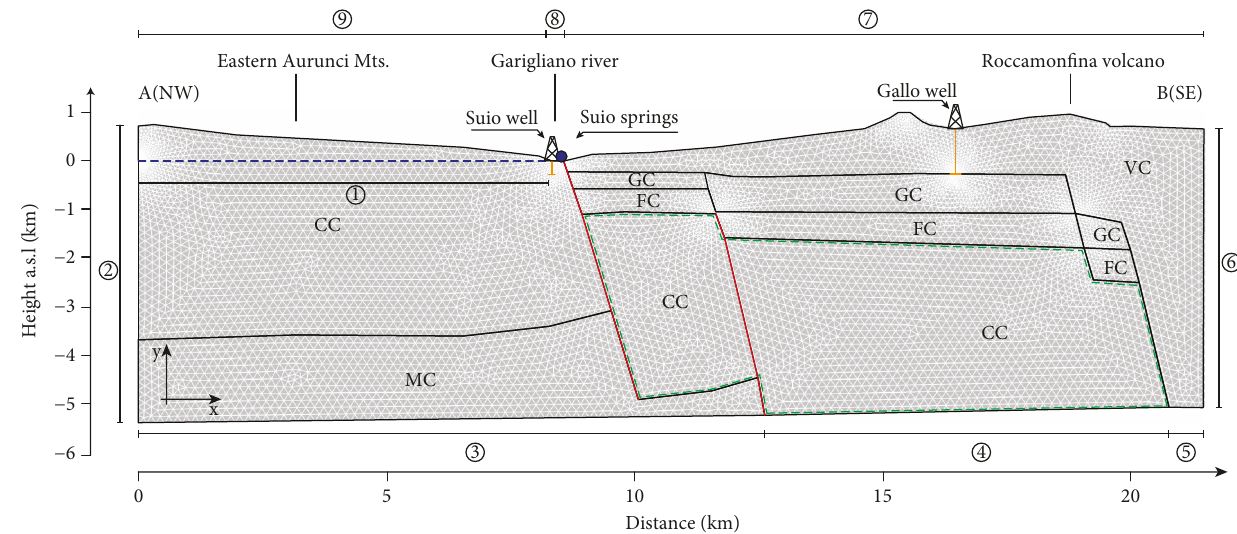
Figure 4: A 2D fi nite element model derived from the hydrogeological section in Figure 1(c). The model shows the location of the temperature measurement points of the Suio springs and at the bottom of the Gallo well and the Suio water wells along the Garigliano river. The area bordered by the green dashed polygon represents the deep reservoir. The dashed blue line represents the piezometric level inside the carbonates. The two red segments (a and b) represent the modelled discrete fractures. For the nomenclature of each layer, please refer to the caption of Figure